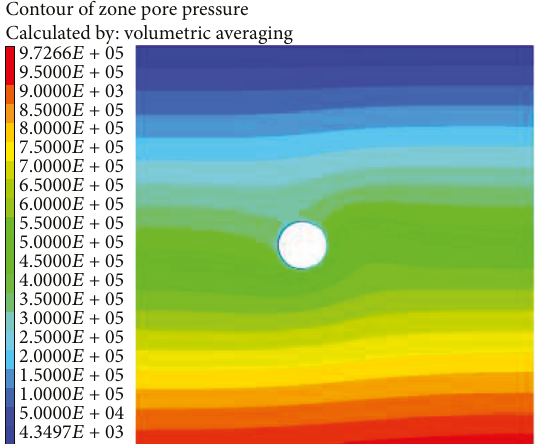
Figure 5: Contour of pore water pressure considering gravity for d = 15 , r = 7 , and r = 4 . w